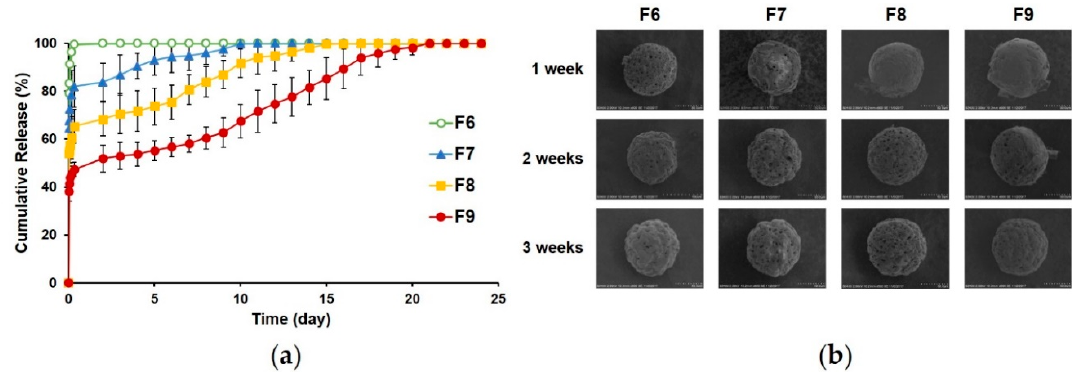
Figure 6. In vitro release of porous (F6) and pore-closed (F7–9) PLGA MS. ( a ) Cumulative release data (mean ± SD, n = 3) and ( b ) morphology of each formulation during in vitro release test. PLGA, poly(lactide- co -glycolide); MS, microspheres.